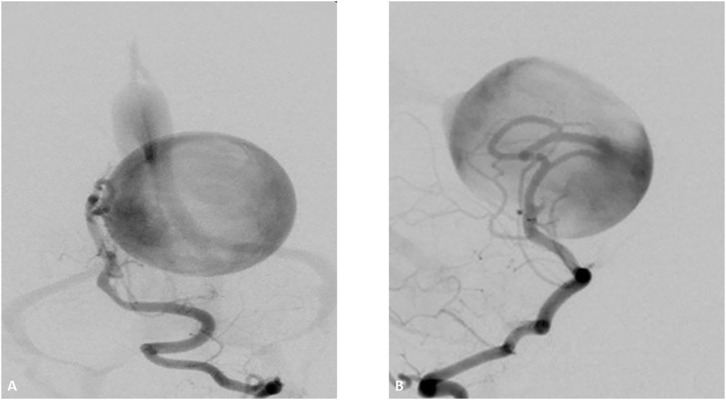
Two-month-old boy presenting with respiratory distress and increase obtundation. Vertebral DSA AP (A) and lateral (B) show a high-flow Mural type Vein of Galen Malformation with feeders arising from the right posterior cerebral artery and draining in to the anterolateral wall of a dilated vein of Galen. There is mild stenosis of the median prosencephalic vein decreasing the venous shunt. The transverse and sigmoid sinuses have normal appearance.